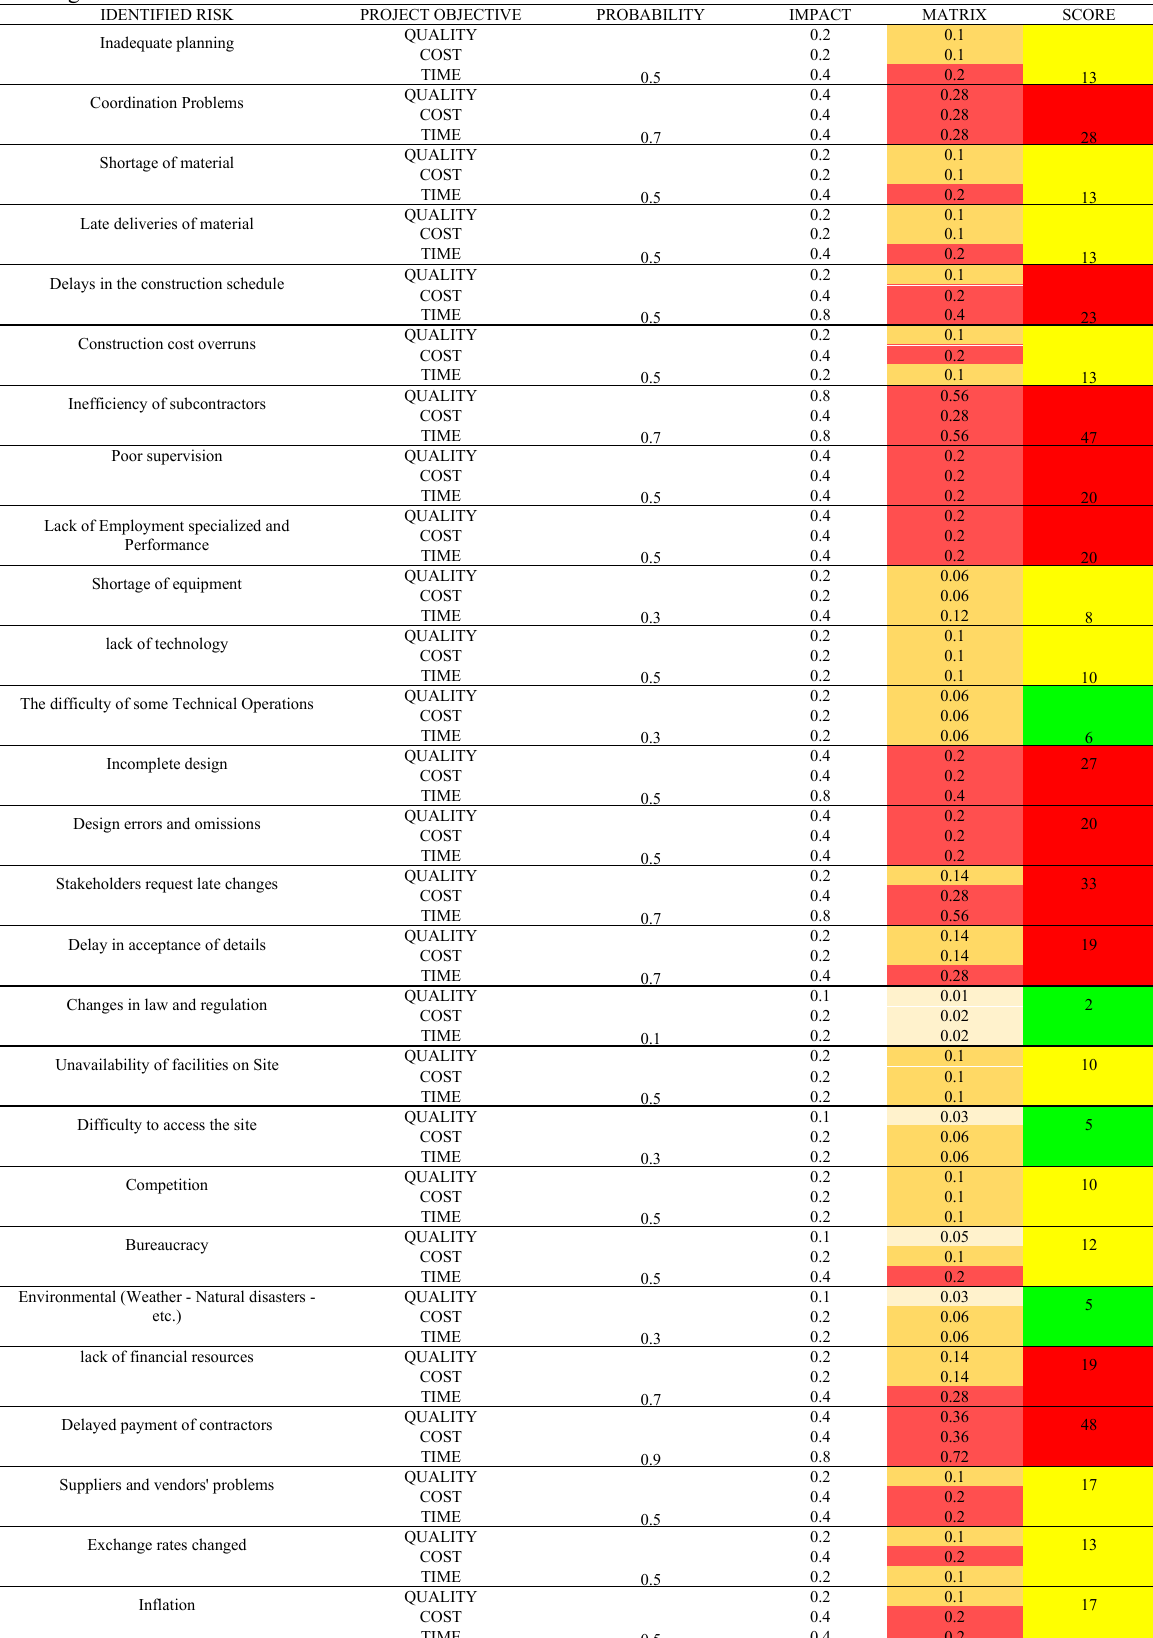
Ranking of risk factors IDENTIFIED